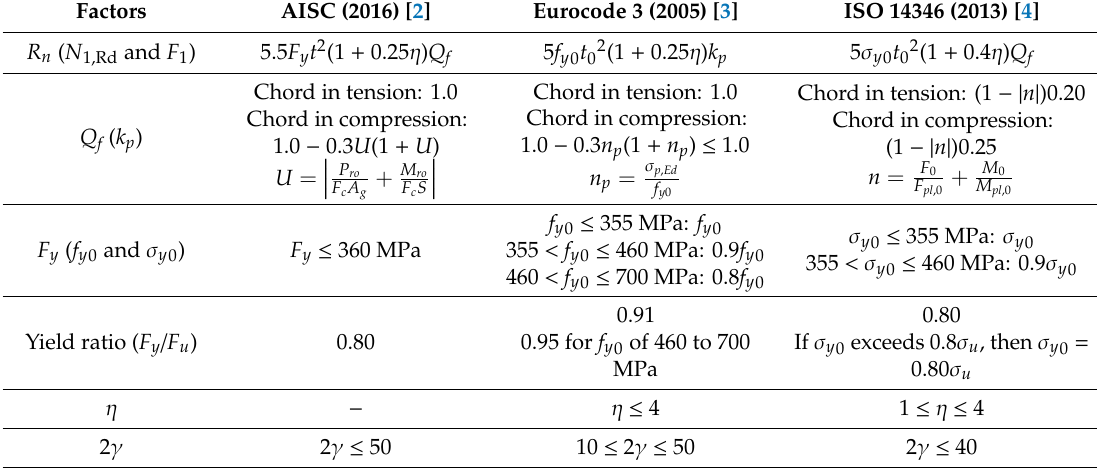
Table 1. Design equations and limitations of plate-to-circular hollow-section X-joint (CHS XP).